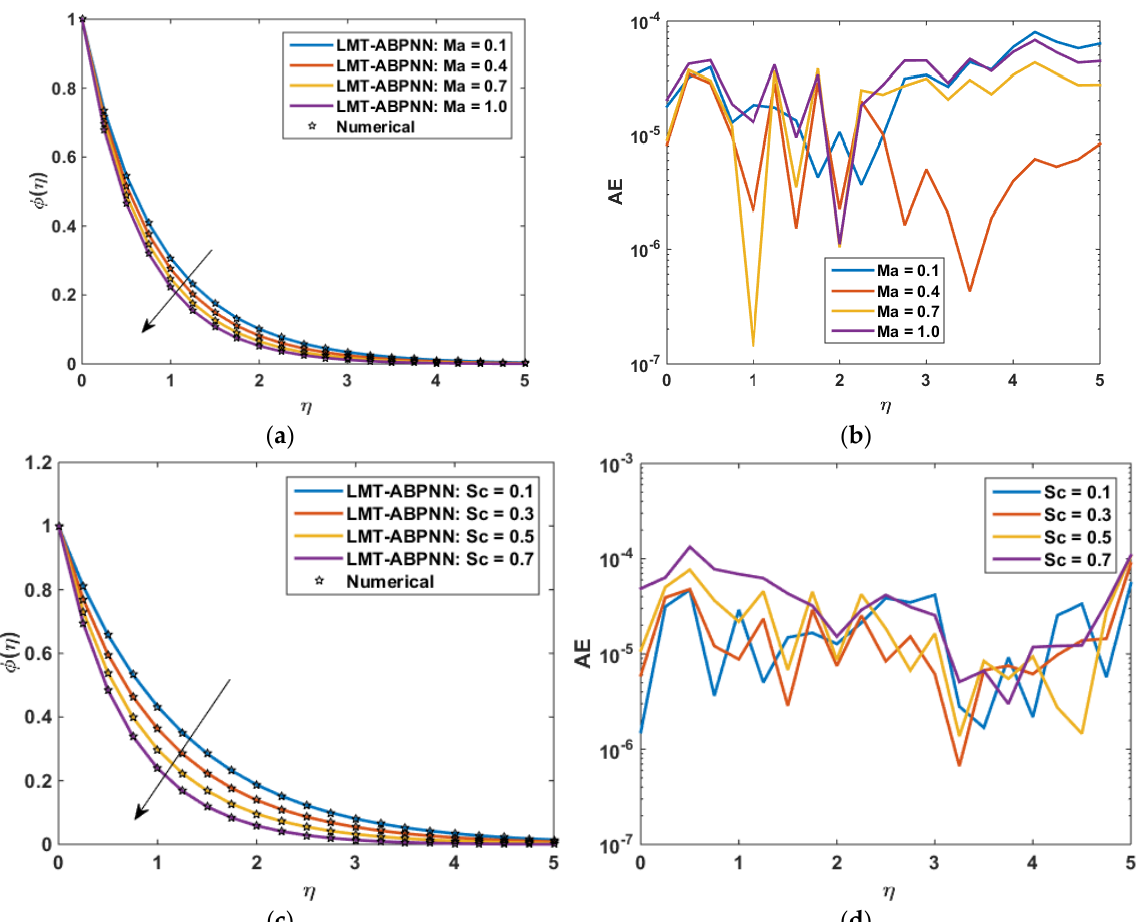
𝜂 ) Figure 15. Assessment of LMT-ABPNN for 𝜙( with reference dataset of MHD-SGFM. ( a ) For variation of 𝑀𝑎 for 𝜙, Figure 15. Assessment of LMT-ABPNN for φ ( η ) with reference dataset of MHD-SGFM. ( a ) For variation of Ma for φ , ( b ) ( b ) AE for MHD-SGFM, ( c ) For variation of 𝑆𝑐 for 𝜙 , ( d ) AE for MHD-SGFM. AE for MHD-SGFM, ( c ) For variation of Sc for φ , ( d ) AE for